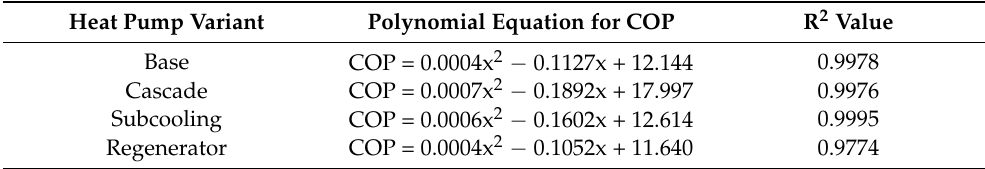
Table 3. Polynomial equation of COP approximation with supply temperature as an argument.